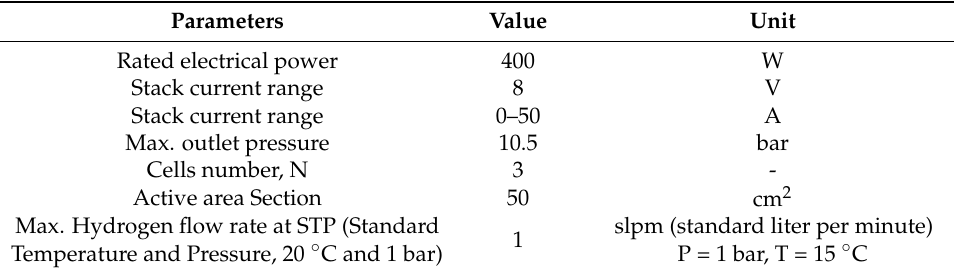
Table 1. Specifications of the proton exchange membrane (PEM)